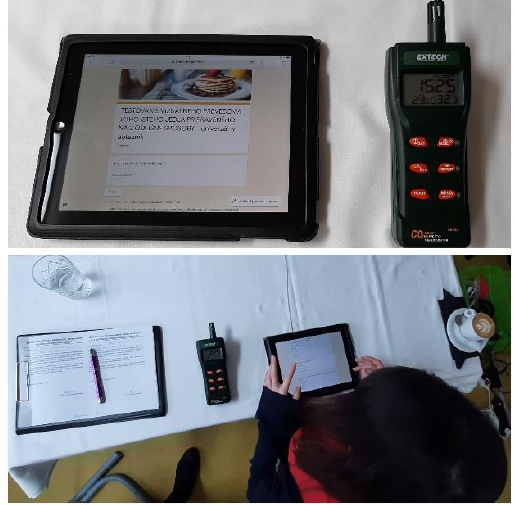
Figure 3. Introductory interview and monitoring of indoor air quality.